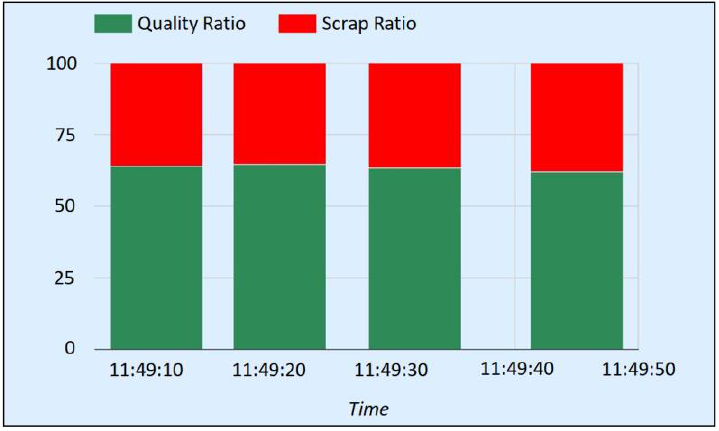
Figure 14. Quality Ratio KPI of the order produced.